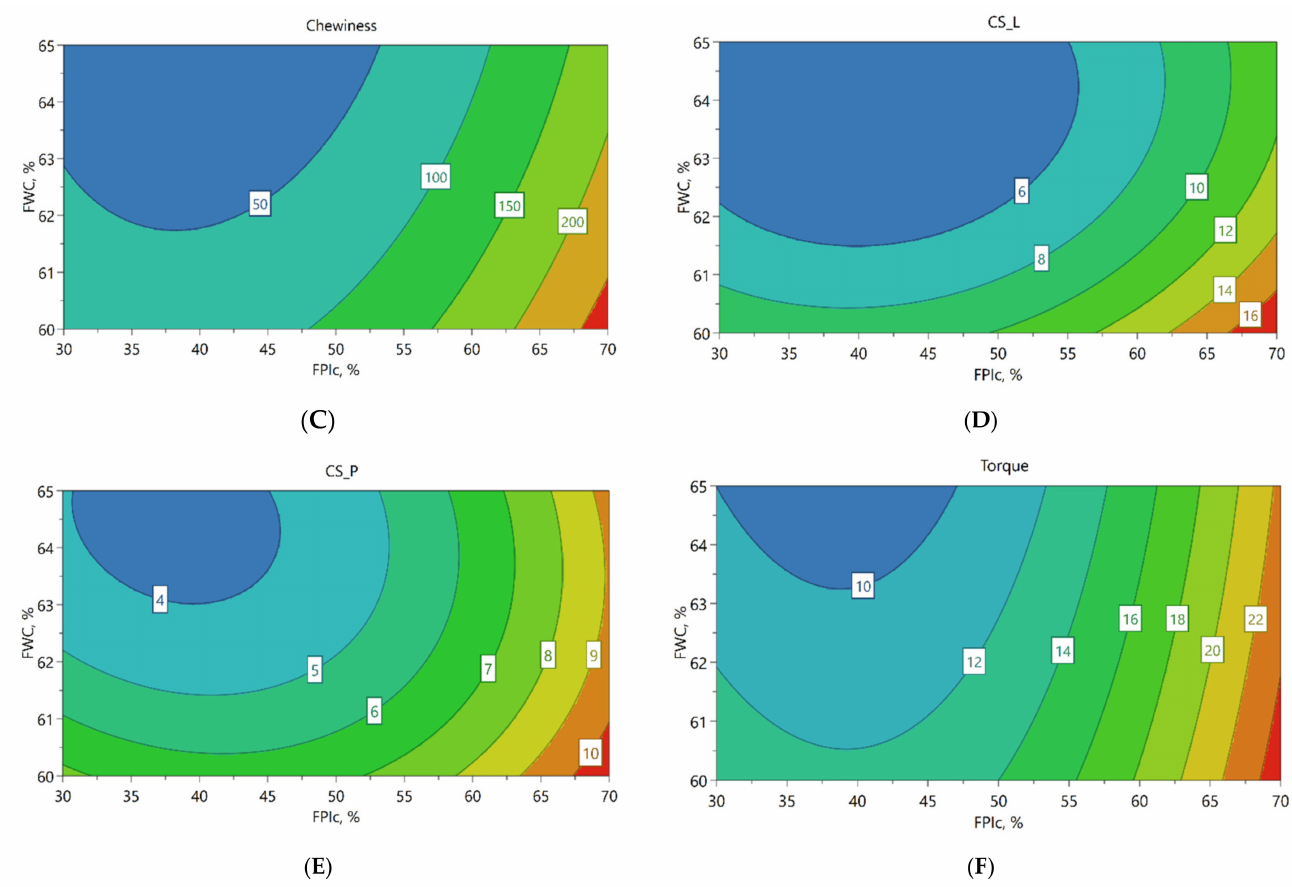
Figure 2. Contour plots from the MLR model showing the effect of feed water content (FWC) and faba bean protein isolate content (FPIc) on the hardness ( A ), gumminess ( B ), chewiness ( C ), cutting strength longitudinal ( D ), and cutting strength perpendicular ( E ) of the meat analogues and the torque ( F ) during extrusion, when the LT was 60 ◦